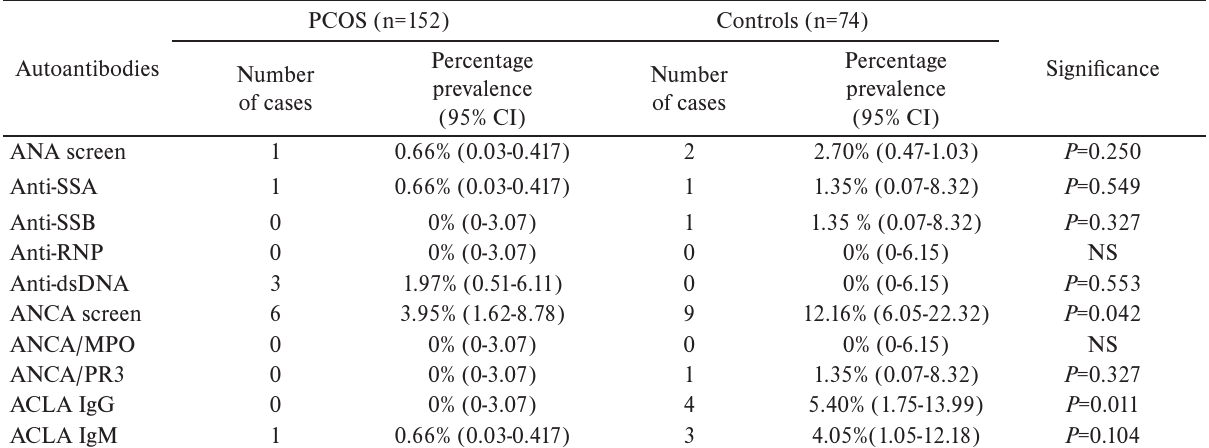
Table 1. Prevalence of non organ specific autoantibodies in PCOS women and controls.